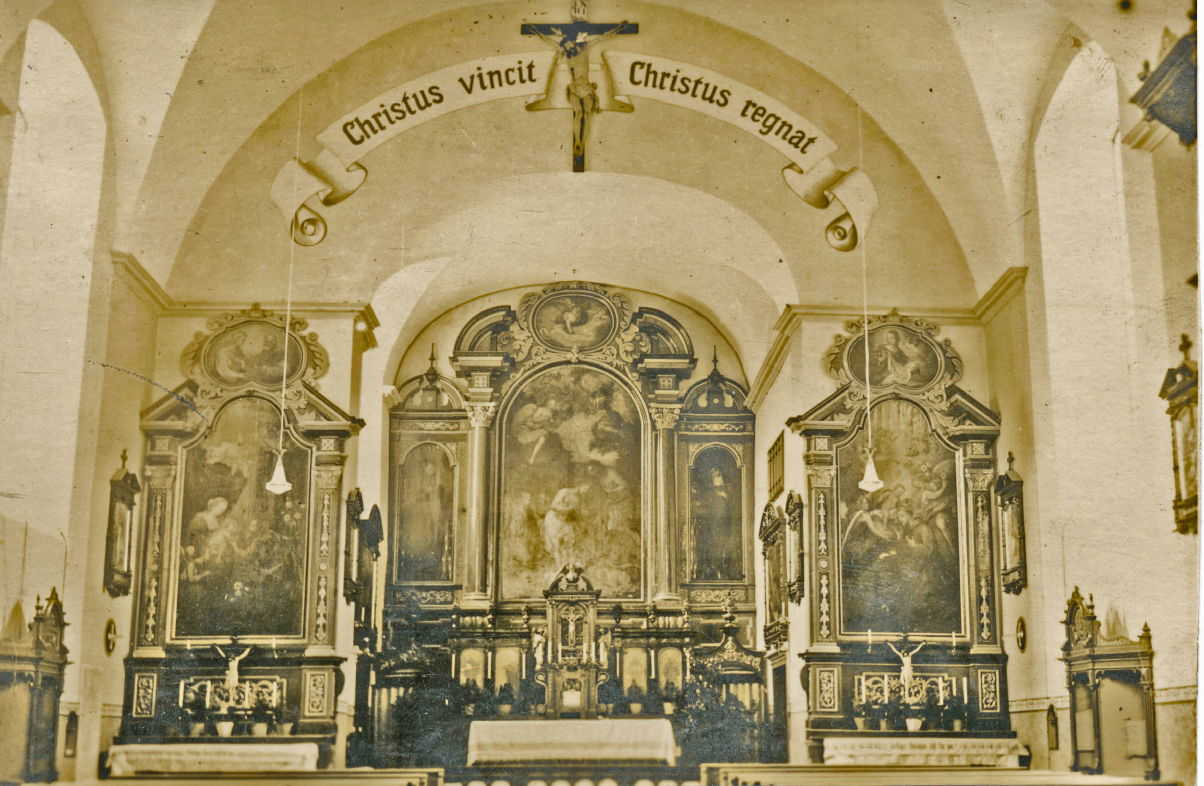
Figure 1: Historical photograph 1 showing the desired altar ensemble as it was before World War II